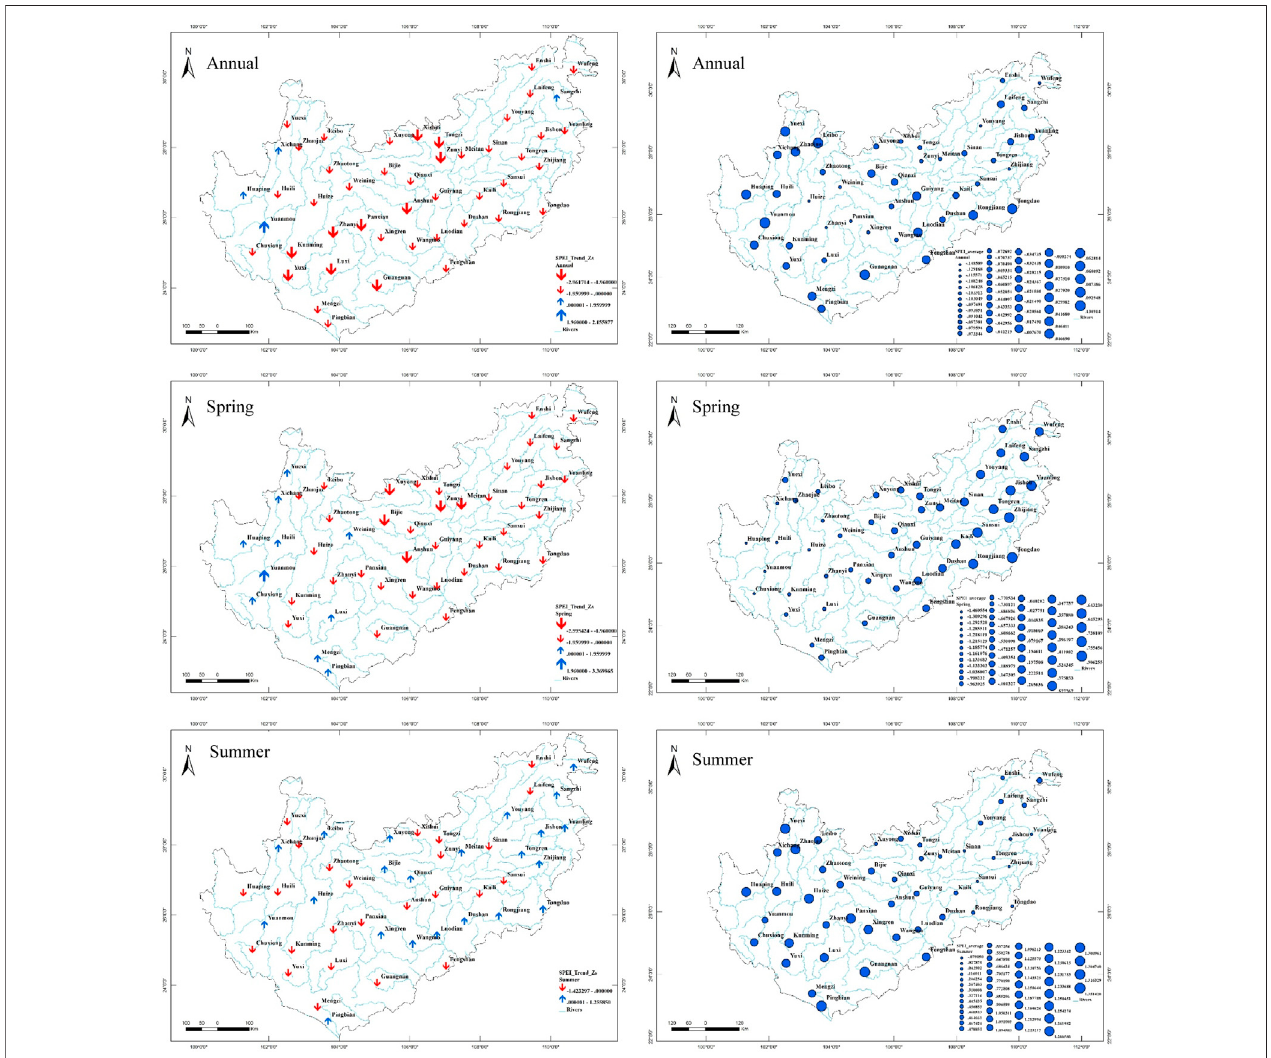
FIGURE 3 | Variation trend of the SPEI and distribution of the multiyear average SPEI on the YGP. The left side represents the variation trend of the SPEI; the right siderepresentsthemultiyearaverageSPEI.Thedownwardarrowindicatesadecrease,andthelargerarrowindicatesasigni fi cantdecreaseatcon fi dencelevel α (cid:1) 0.05. The upward arrow indicates an increase, and the larger arrow indicates a signi fi cant increase at con fi dence level α (cid:1) 0.05.